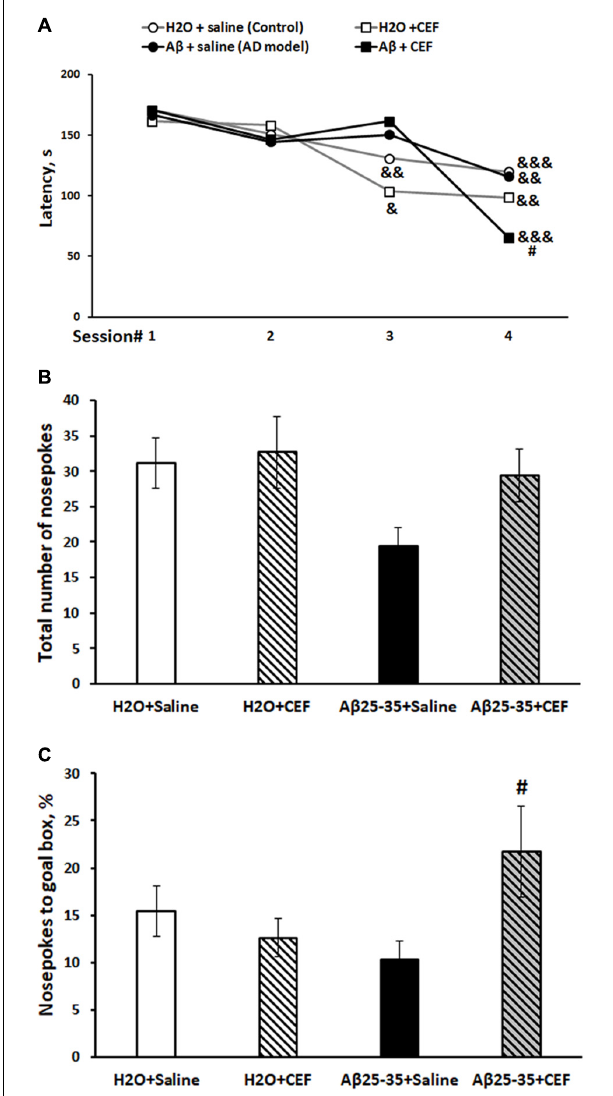
FIGURE 2 | Effects of the CEF and A β 25–35 administration (AD model) on spatial memory and learning in mice in the Barnes test. (A) Episodic memory and learning were evaluated by the latency (s) to find an escape box during the first day of training. (B) General exploratory activity was estimated by the total number of nosepokes on the test day. (C) Long-term spatial memory was evaluated by the percentage of nosepokes to the target hole on the test day. The data are expressed as mean ± SEM of the values obtained in an independent group of animals ( n = 7–15 per group). Statistically significant differences: & p < 0.05, && p < 0.01, &&& p < 0.001 compared with values of the same group on the first training session; # p < 0.05 compared with respective values of the “A β + saline”